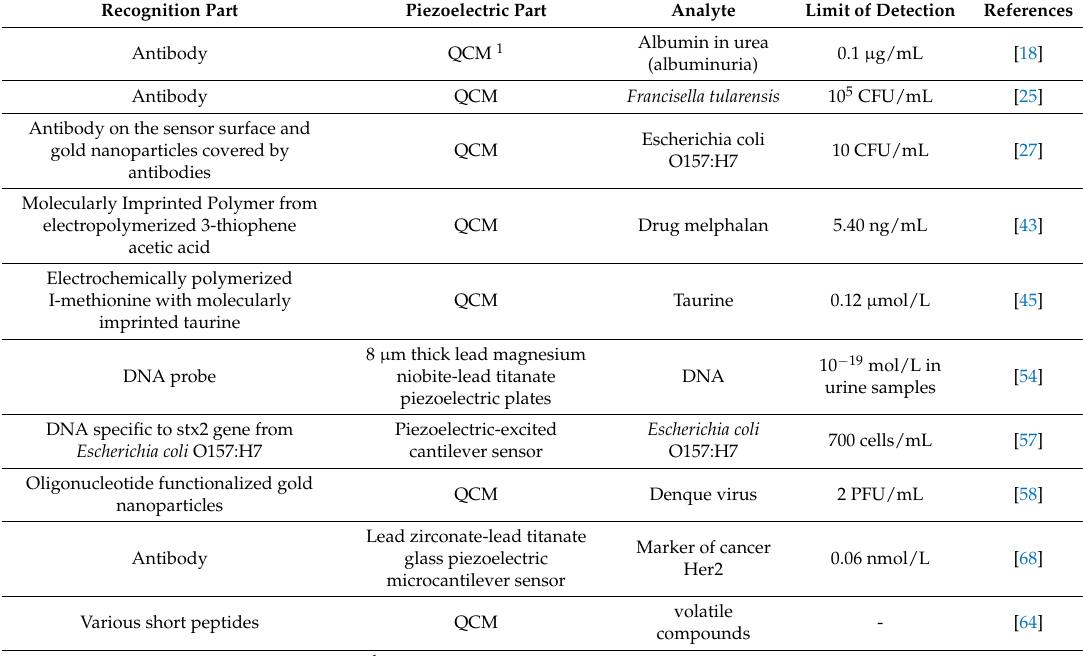
Survey of papers devoted to biosensors and the other analytical devices using piezoelectric